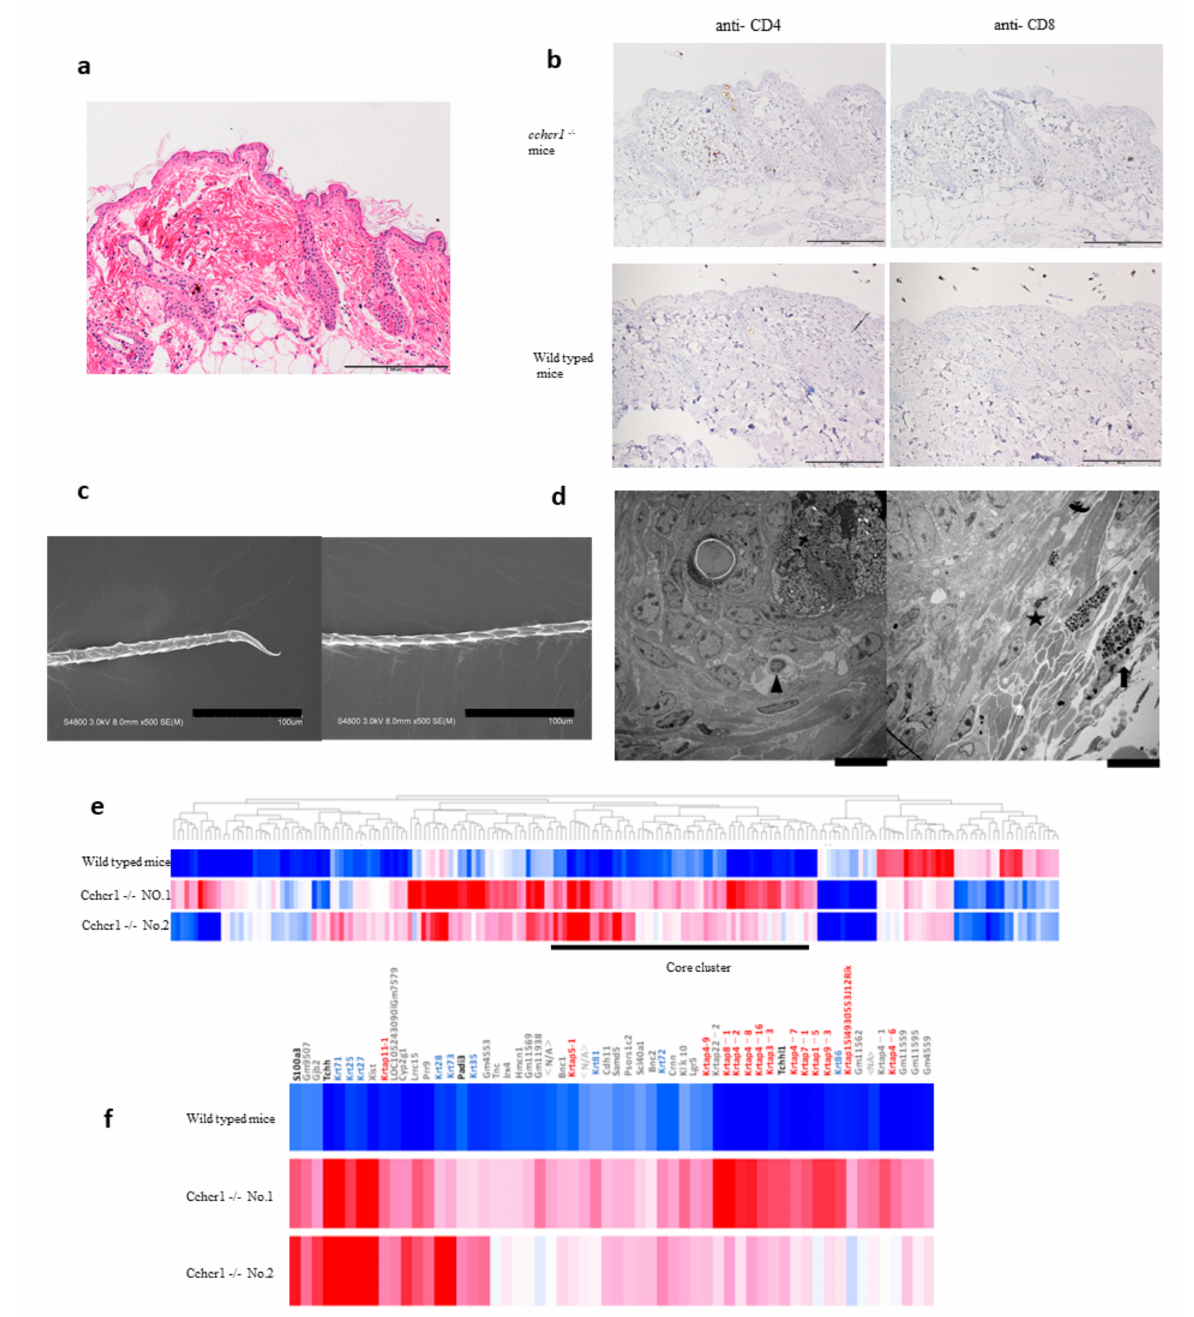
Figure 3. Morphological changes and genetic analysis. ( a ) Histological analysis of alopecic lesions in cchcr1 − / − mice using HE staining revealed follicles with little inflammatory lymphocytic infiltration in the peribulbar region (HE staining; scale bar = 200 µ m). ( b ) IHC staining of the skin using CD4+ and CD8+ antibodies showed peribulbar lymphocytic inflammation in alopecic lesions in cchcr1 − / − mice (IHC staining; scale bar = 200 µ m). ( c ) SEM examination of the hair shafts of cchcr1 − / − mice. Exclamation mark hairs (left panel) and abnormal hair shaft formation (right panel) were observed (scale bar = 100 µ m). ( d ) TEM examination of the skin from alopecic lesions on cchcr1 − / − mice revealed lymphocytes, dark cells, and mast cells in a perifollicular location (left panel). Apoptosis in the outer root sheath of catagen follicles, matrix keratinocytes and anagen hair bulbs was observed (right panel) (Scale bar = 10 µ m). ( e ) Expression analysis of cchcr1 -/- mice. Heat map of 196 probes showing ≥ 4-fold change in gene expression. ( f ) Heat map of core cluster genes. The color code depicts KRTAP family (red), keratin family (blue), other hair-related (black), and nonhair-related (gray)